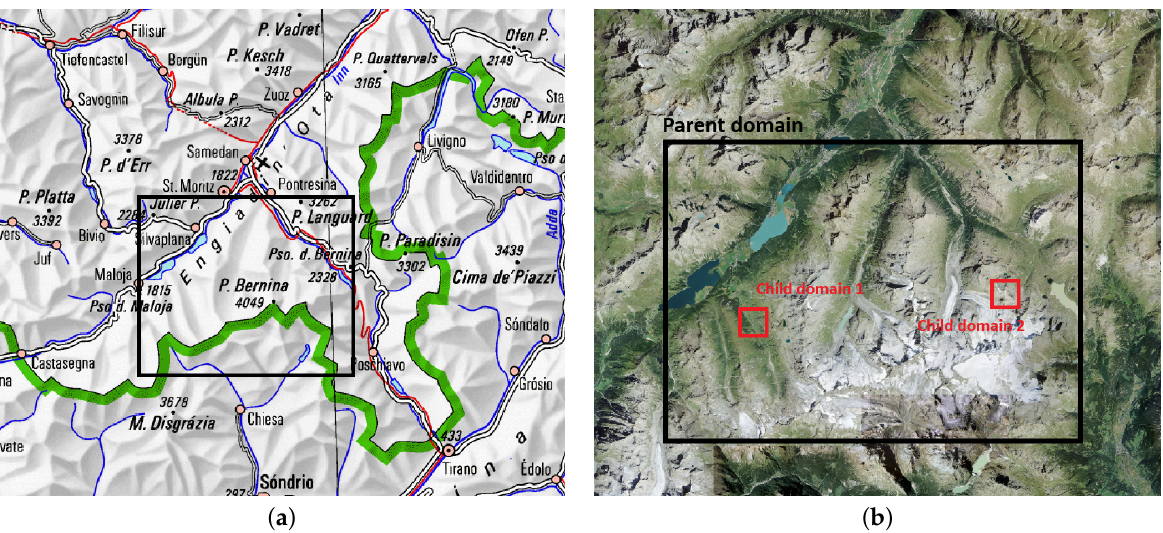
Figure 4. PALM simulation domain for the mountainous region Samedan indicated in ( a ) national map of Switzerland with relief, in ( b ) SWISSIMAGE (source of the original images: the Federal Office of Topography in Switzerland). The border between Switzerland and Italy is displayed in green in ( a ). The black frame in each subfigure represents the parent domain defined in the present case. The red frames in ( b ) indicate the child domains of the parent